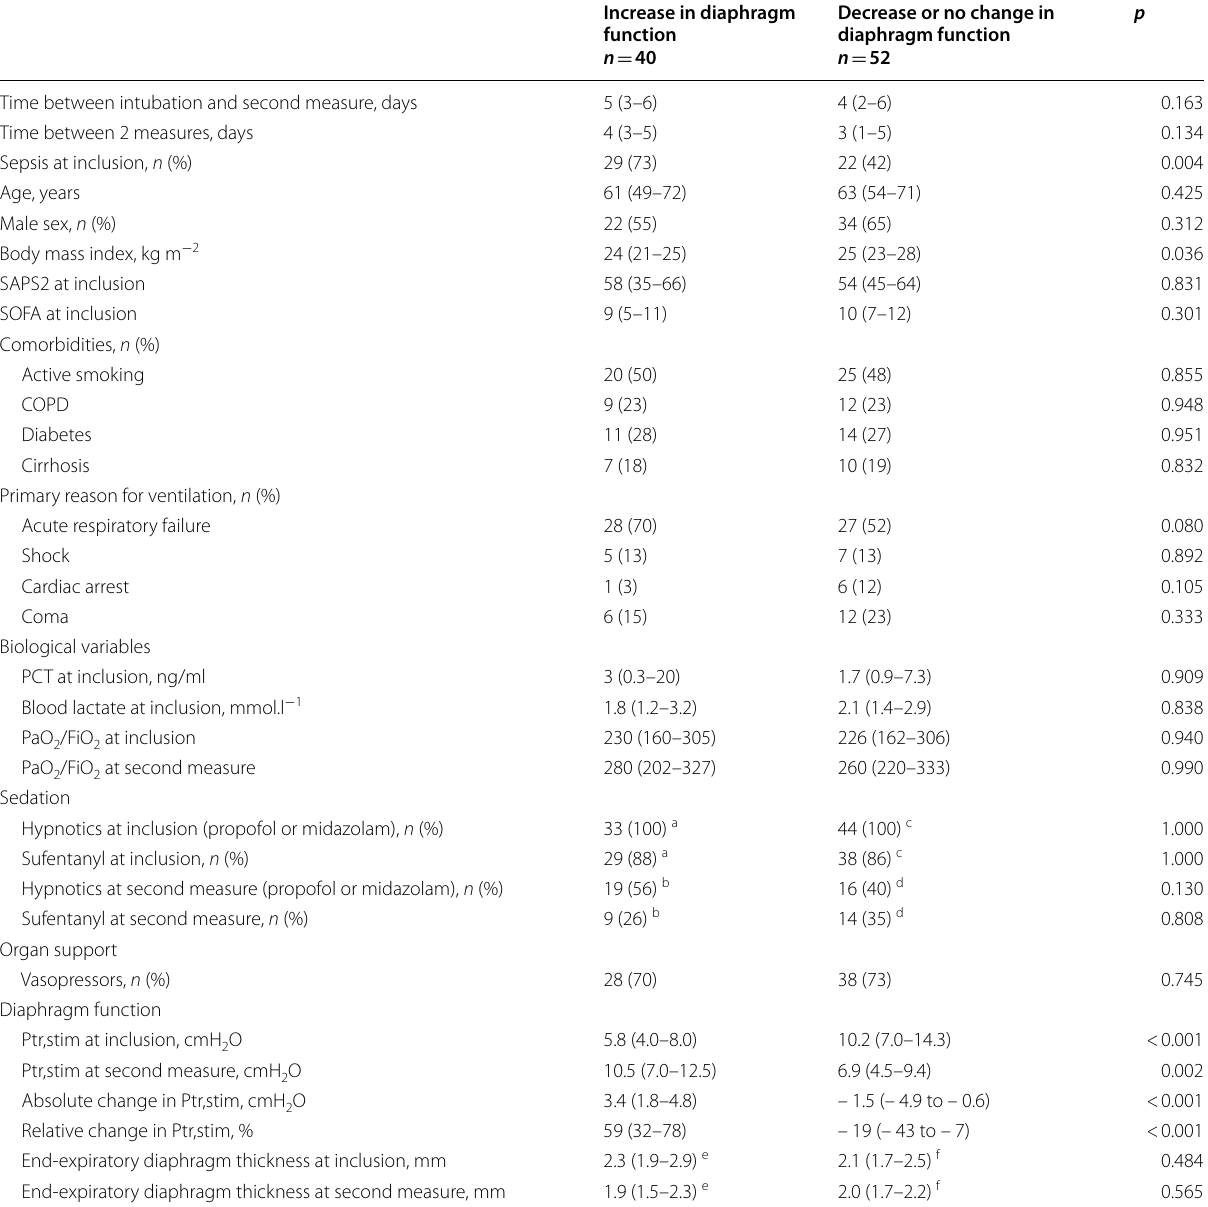
Table 2 Variables associated with an increase in diaphragm function* and a decrease or no change in diaphragm function between the two measurements